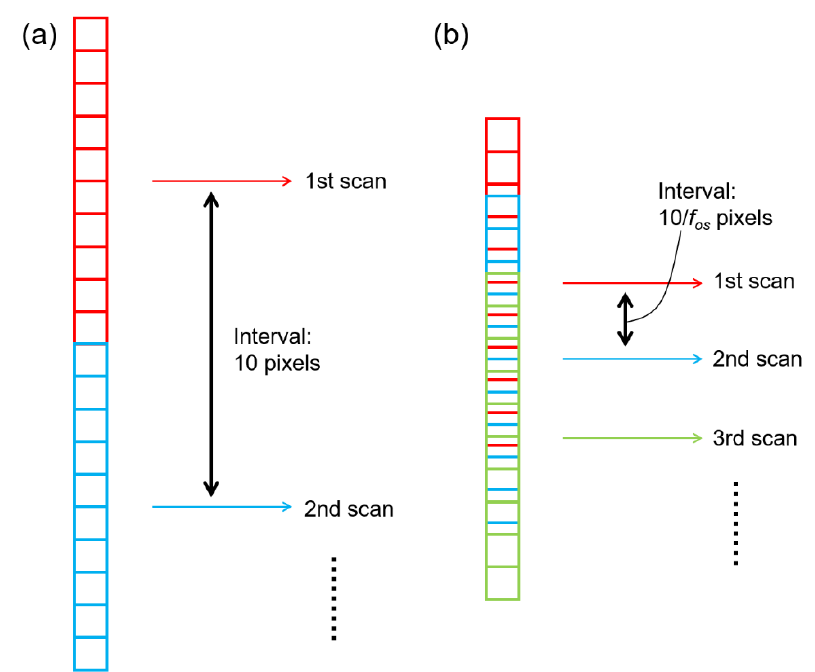
Figure A1. Schematic views of TIR’s whiskbroom observations in ( a ) a nominal observation condition and ( b ) an oversampling condition. Note that each TIR band has 10 detectors and the actual TIR detectors are aligned with a stagger configuration.